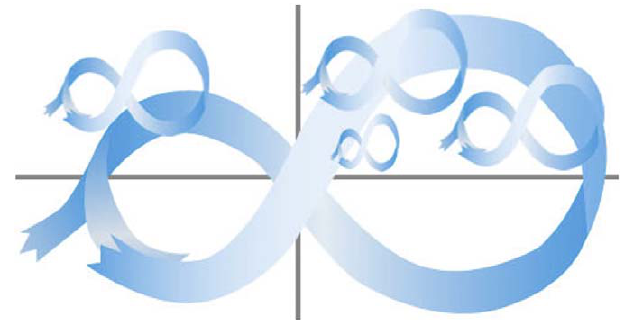
Figure 3. Representation of a dynamic and stable institutional